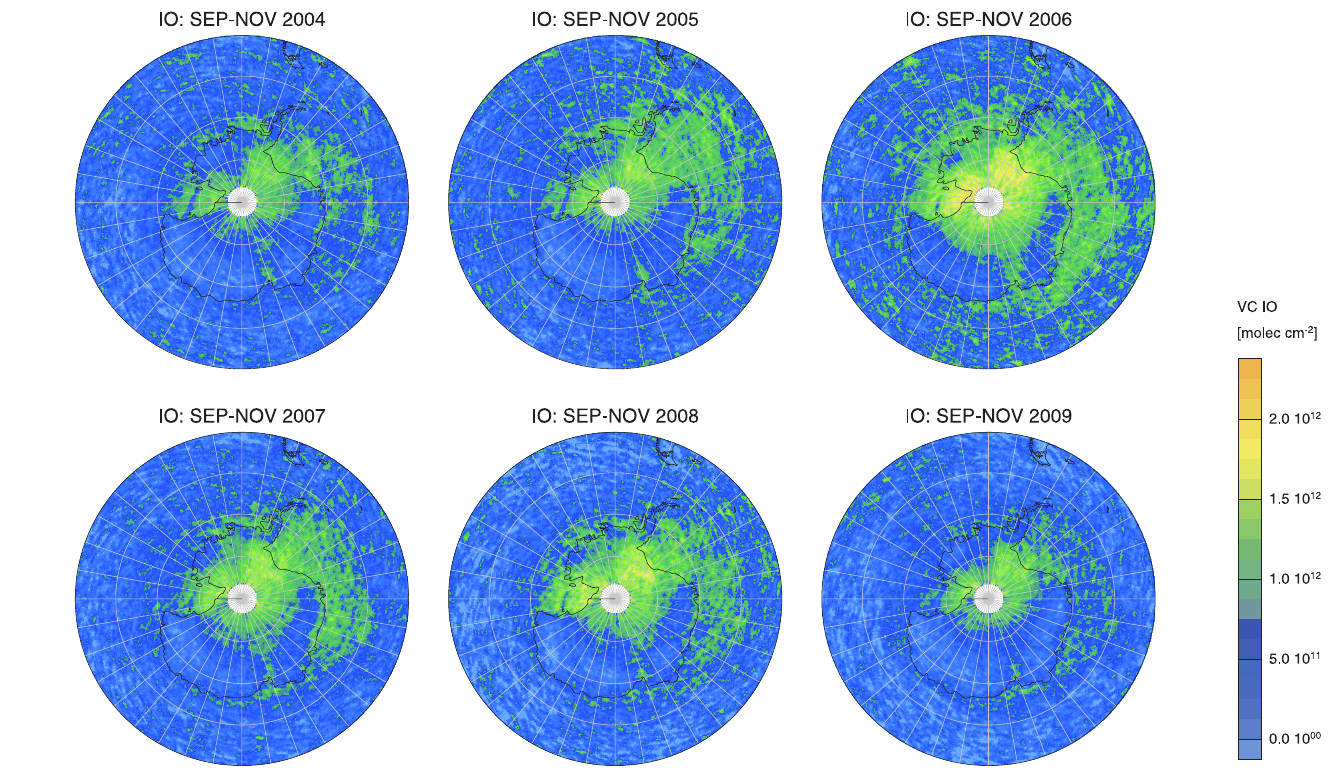
Fig. 3. Spring time averages (September–November) of IO vertical column amounts above the Southern Hemisphere (from 90 ◦ S to 50 ◦ S) for six individual years from 2004 to 2009.